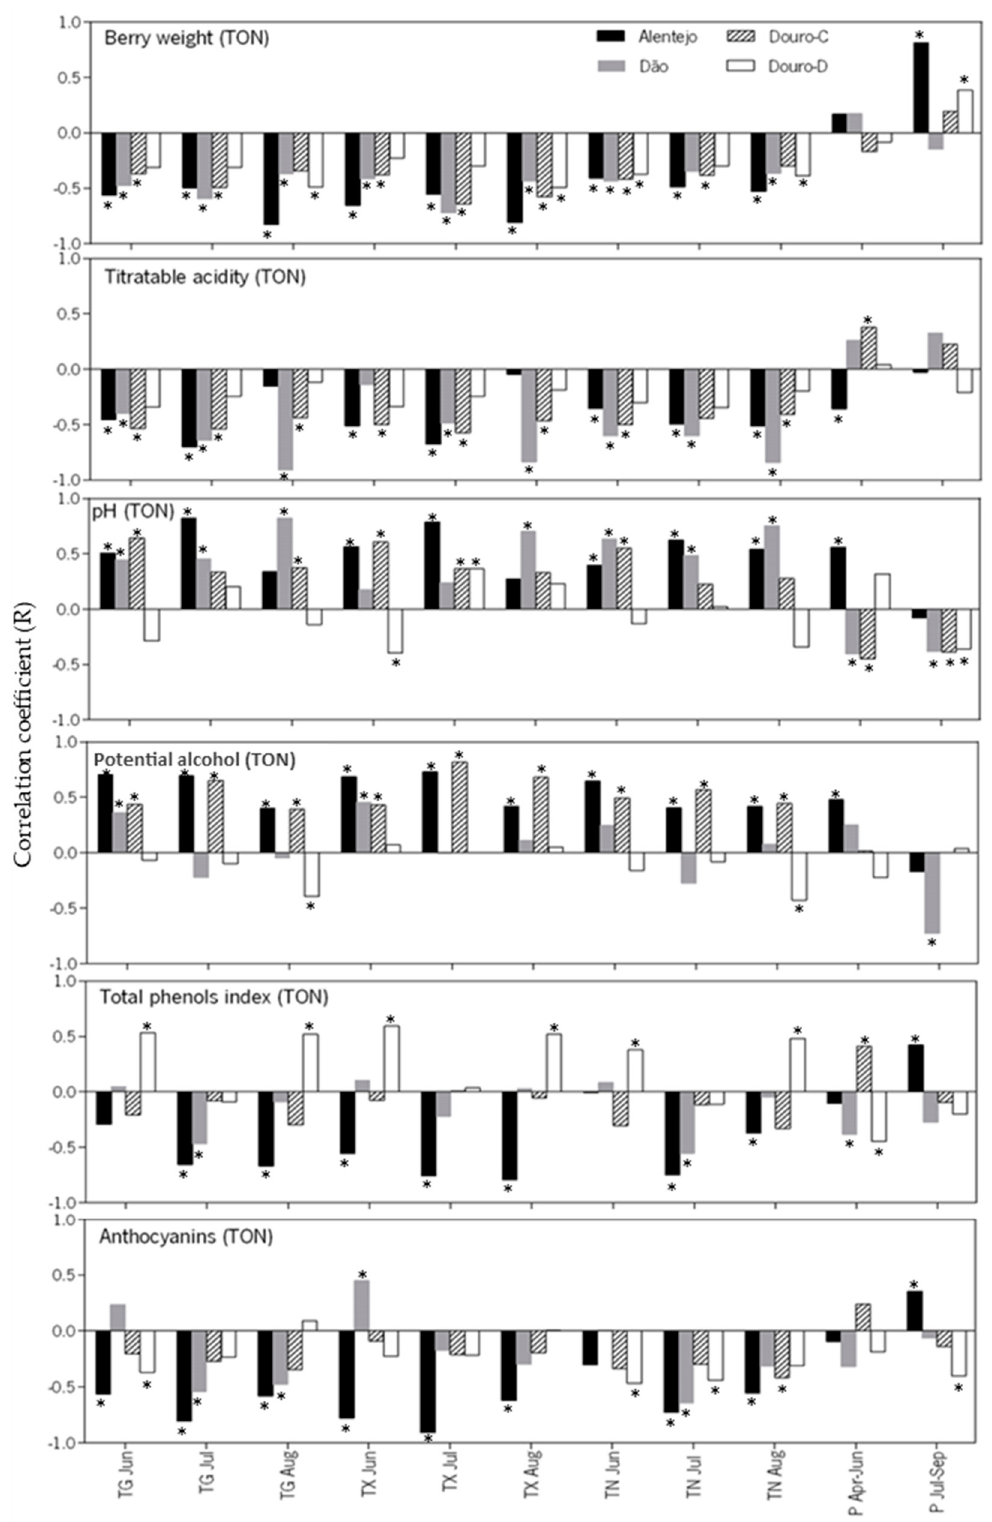
Figure 2. Pearson product-moment correlation coefficients between grape berry quality parameters (berry weight, titratable acidity, pH, potential alcohol, total phenols index and anthocyanins) at maturity and climate variables for cv. Touriga Nacional (TON). Months are described by their initial letters. TG—average temperature; TX—maximum temperature; TN—minimum temperature; P—precipitation. Statistically significant correlation coefficients at 1% significance level are highlighted with an *.